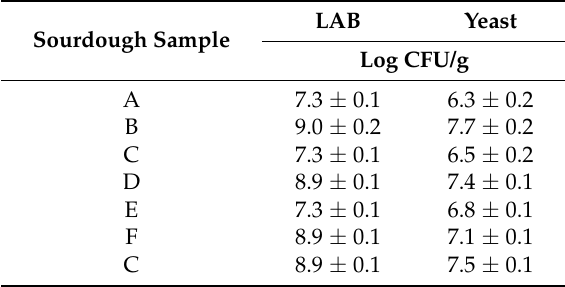
Table 1. Bacterial and yeast cell counts in